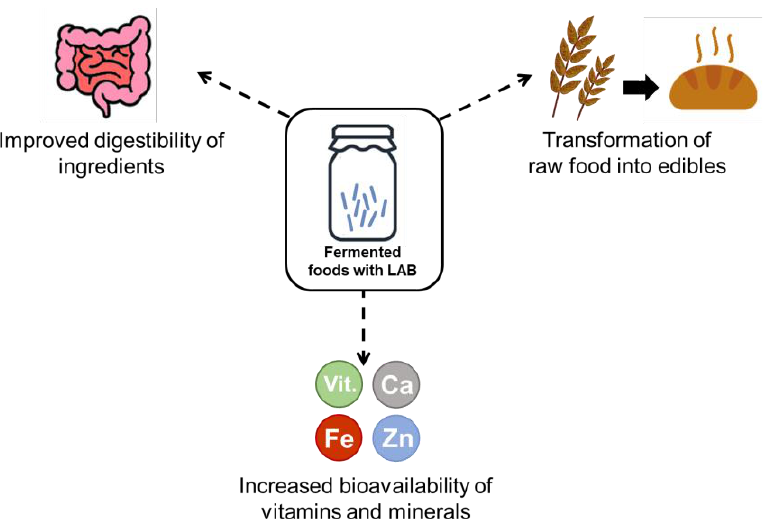
Figure 1. Nutritional improvements produced by lactic acid bacteria (LAB) on raw food ingredients.